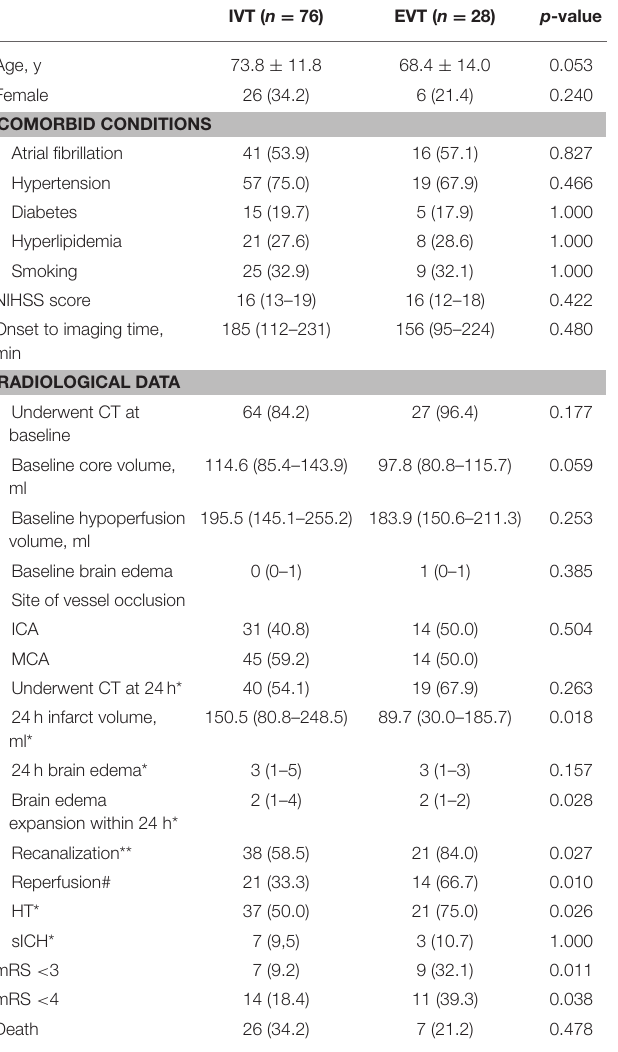
TABLE 2 | Comparison of characteristics between patients with good and poor outcome. Poor outcome ( n =